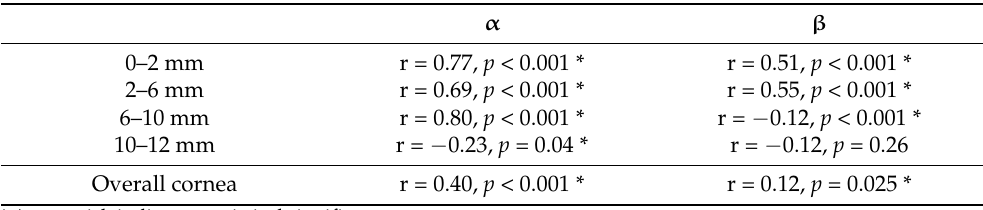
Table 4. The Pearson correlation coefficient and the corresponding p -value of the α and β with age, depending on the corneal area considered. The overall cornea is also considered. Corresponding scatter plots are shown in Figure